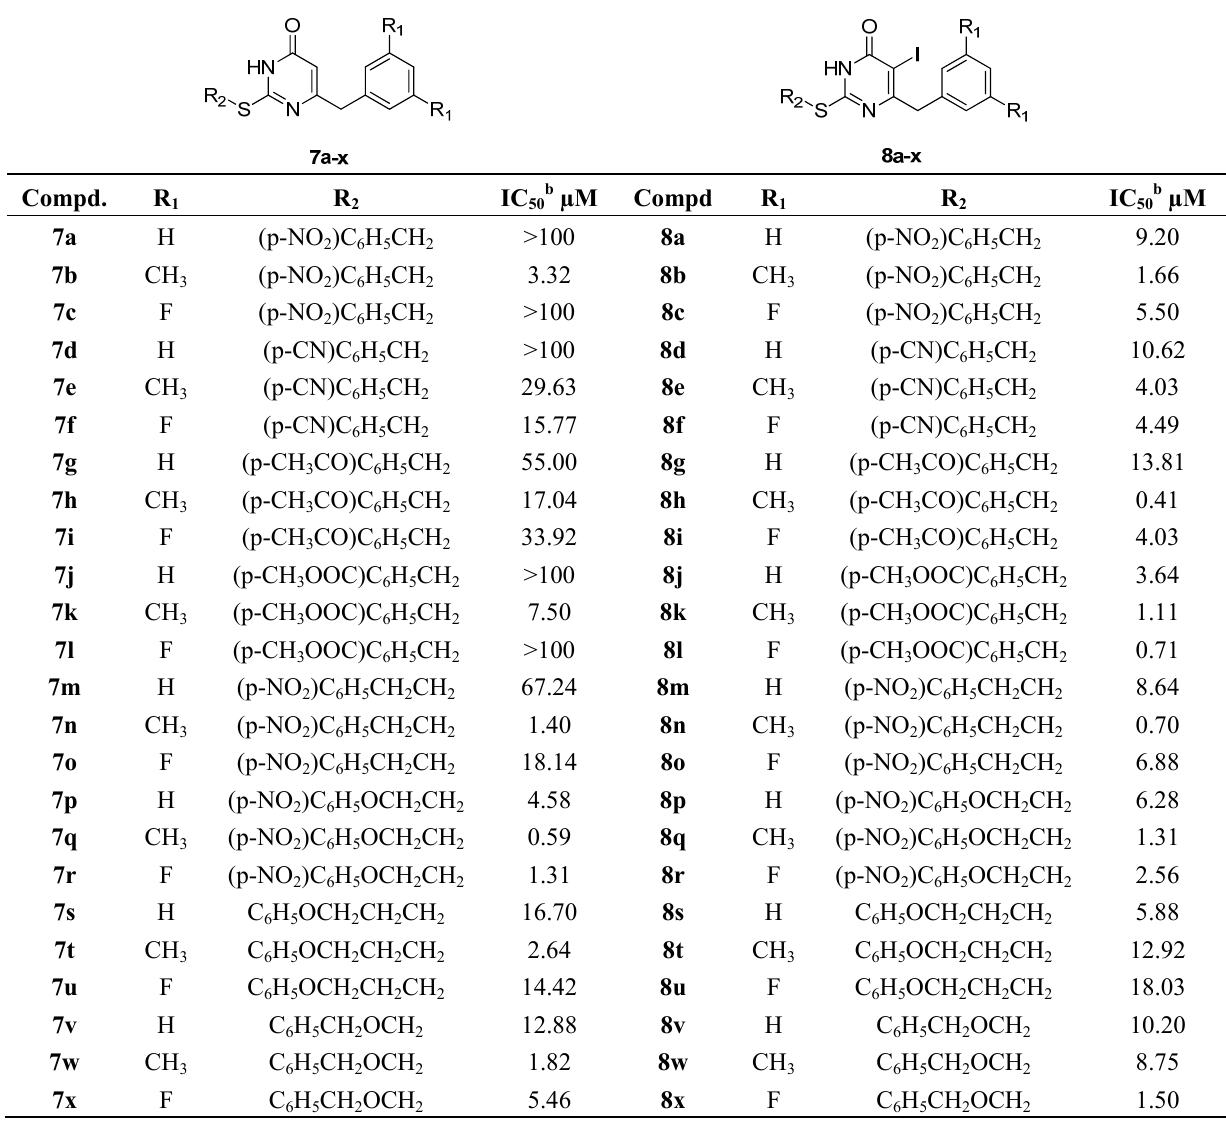
Table 1. Inhibitory Activity of 7a – 8x against HIV-1 RT a